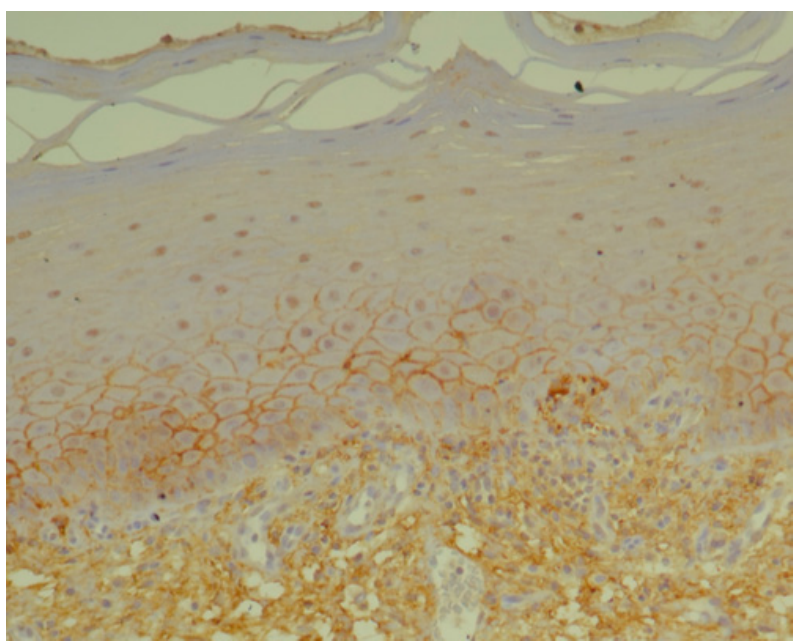
Figure 8. TNF- α —strong brown staining in epithelium (basal and parabasal layer) and stroma of oral lichen planus without dysplasia (OLP) (20x).